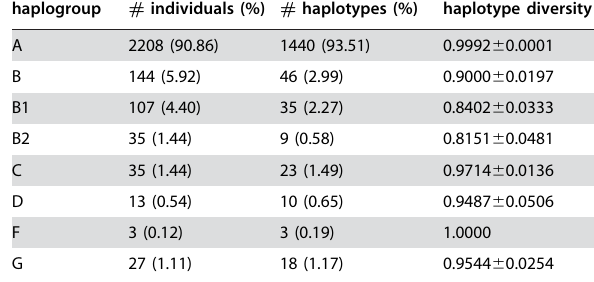
Table 1. Genetic diversity of goat mtDNA haplogroups ... ... ... .... ... ... .... ... ... .... ... ... .... ... ... .... ... ... .... ... ... .